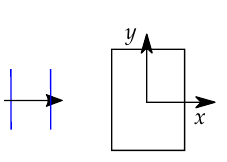
Figure 3. Sketch of a single barge excited by a plane wave travelling along the x -direction.